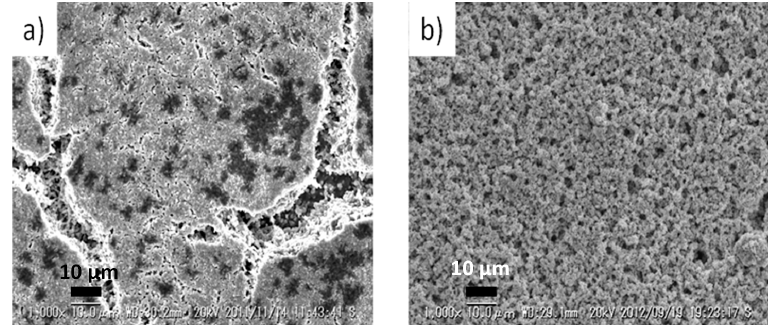
Figure 12. Scanning electron microscopy (SEM) images of LSCF cathodes exposed to different concentrations of sulfur impurity in the gas stream during electrochemical measurements of the degradation process, ( a ) 1513 ppm S; ( b ) 752 ppm S. Taken with permission from Elsevier, from [105] by Xie et al.